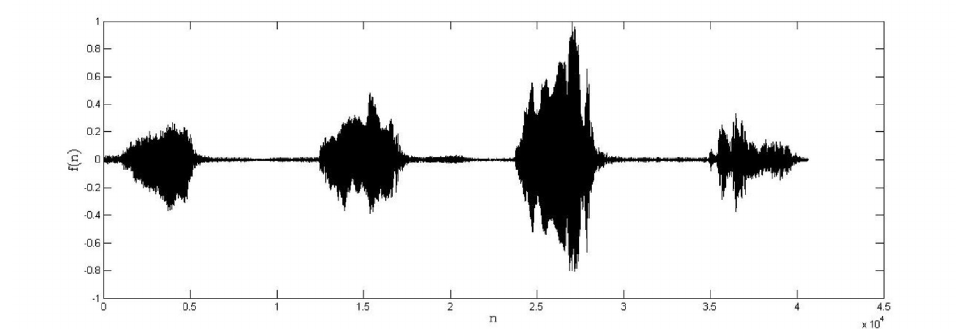
Figure 7. Audio record from a bird vocalization after by-observation region extraction.